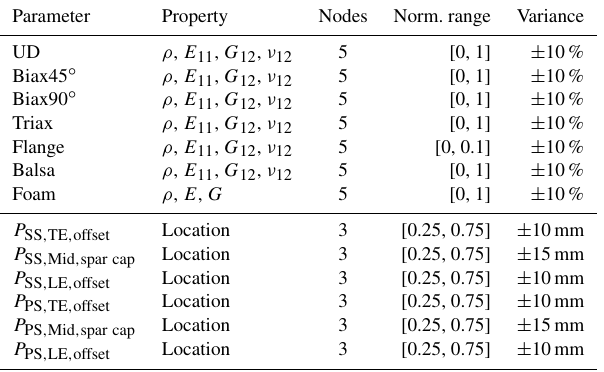
Table 1. Input feature list analyzed in this study. Each feature and property builds a distribution spline based on the given number of equidistant nodes within the given normalized radial range of the blade. Each node value may then vary in the listed variance range. Parameter Property Nodes Norm. range